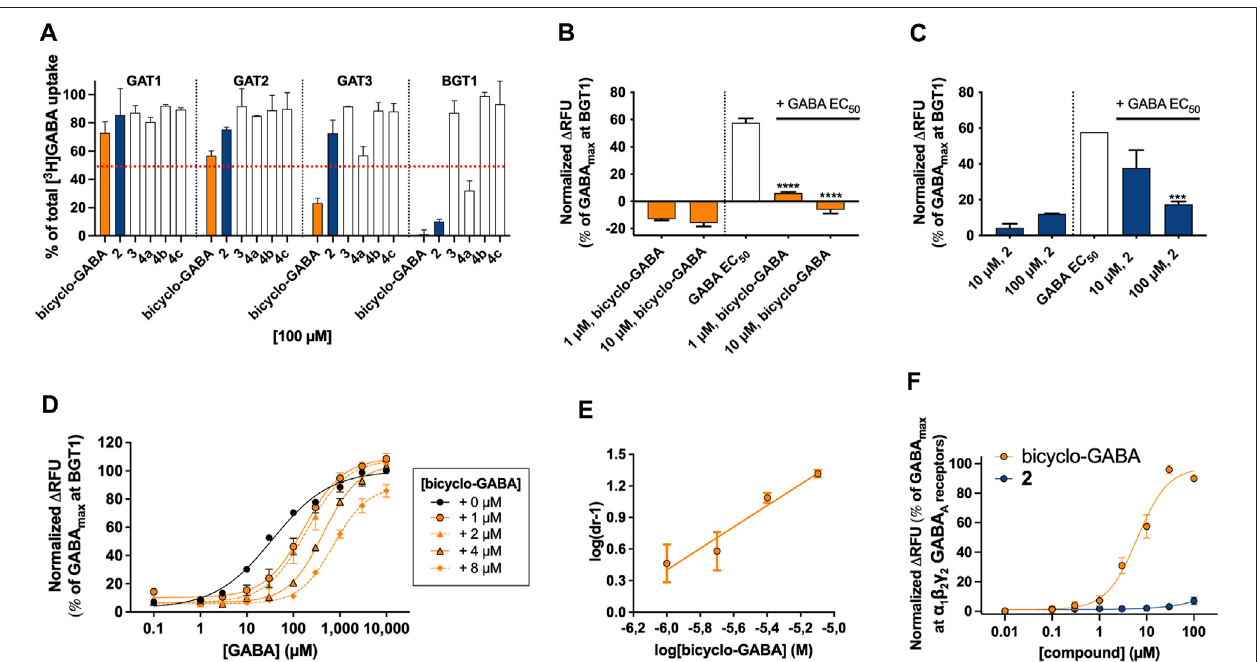
FIGURE5|(A) PharmacologicalanalysisofcyclicGABAanalogsinthe[ 3 H]GABAuptakeassayatthefourhumanGATs.Percentageinhibitionof[ 3 H]GABAuptake byanalogsat100 µMconcentrations.Datashownarepooledandnormalizedto100%[ 3 H]GABAuptakewiththedashedredlineindicating50%inhibition( n (cid:1) 2). (B – C) Inhibitory, but not substrate, activity of the two most potent bicyclo-GABA analogs at BGT1 in the FMP assay. Data shown are pooled and normalized responses (% of GABA max at BGT1) of (B) bicyclo-GABA (n (cid:1) 4) and (C) 2 ( n (cid:1) 2) without and with GABA EC 50 (25 µM GABA) present. (D – E) Gaddum-Schild analysis of bicyclo- GABA, yielding a Schild slope of 1.02 indicative of competitive inhibition with a calculated K B of 0.47 µM ( n (cid:1) 4). (F) Characterization of bicyclo-GABA and 2 at α 1 β 2 γ 2 GABA A receptors by use of the FMP assay. Data in B( – C) were compared to GABA EC 50 by a One-way ANOVA followed by Dunnett ’ s multiple comparison test, signi fi cance levels *** p < 0.001, **** p < 0.0001. Data are presented as means ± S.E.M.